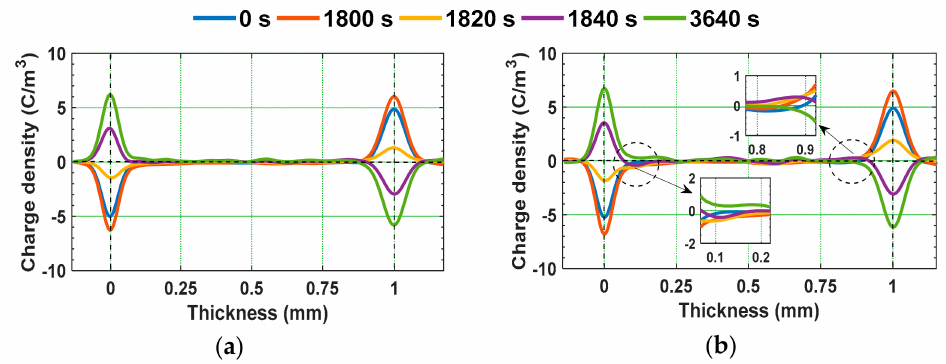
Figure 10. Space charge distribution under polarity reversal from positive to negative DC field stress in ( a ) virgin and ( b ) 8 kGy gamma irradiated specimens